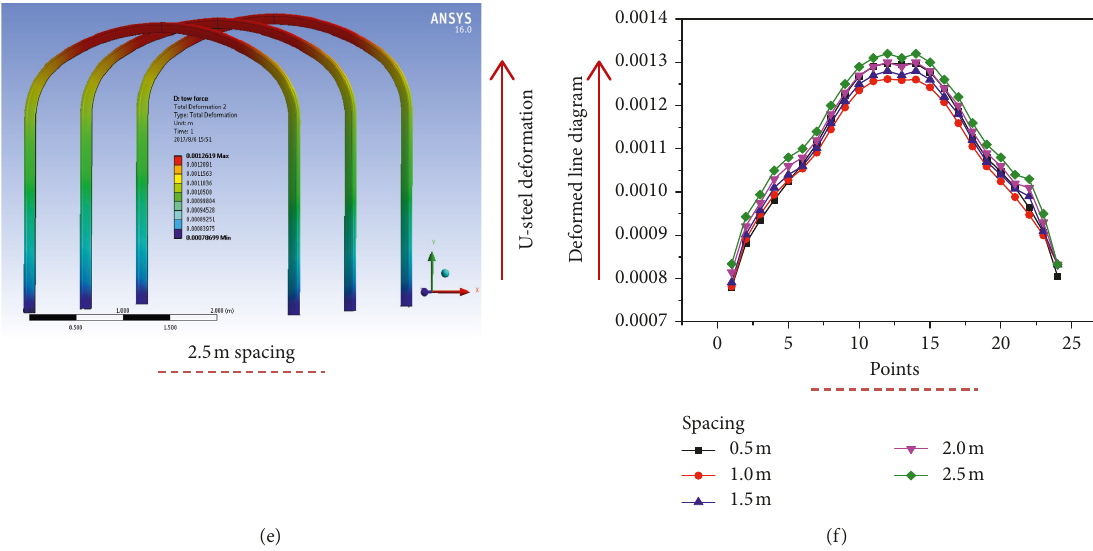
Figure 4: Deformation of the U-shaped steel with different spacings: (a) 0.5m; (b) 1.0m; (c) 1.5m; (d) 2.0m; (e) 2.5 m. They are represented by the curves in black, red, blue, pink, and green, respectively. Blue to red, small to large deformation. The data from the monitoring points are extracted and drawn as the broken line map (f). The maximum values were 1.5502mm, 1.2614mm, 1.2615mm, 1.2617mm, and 1.2619 mm,